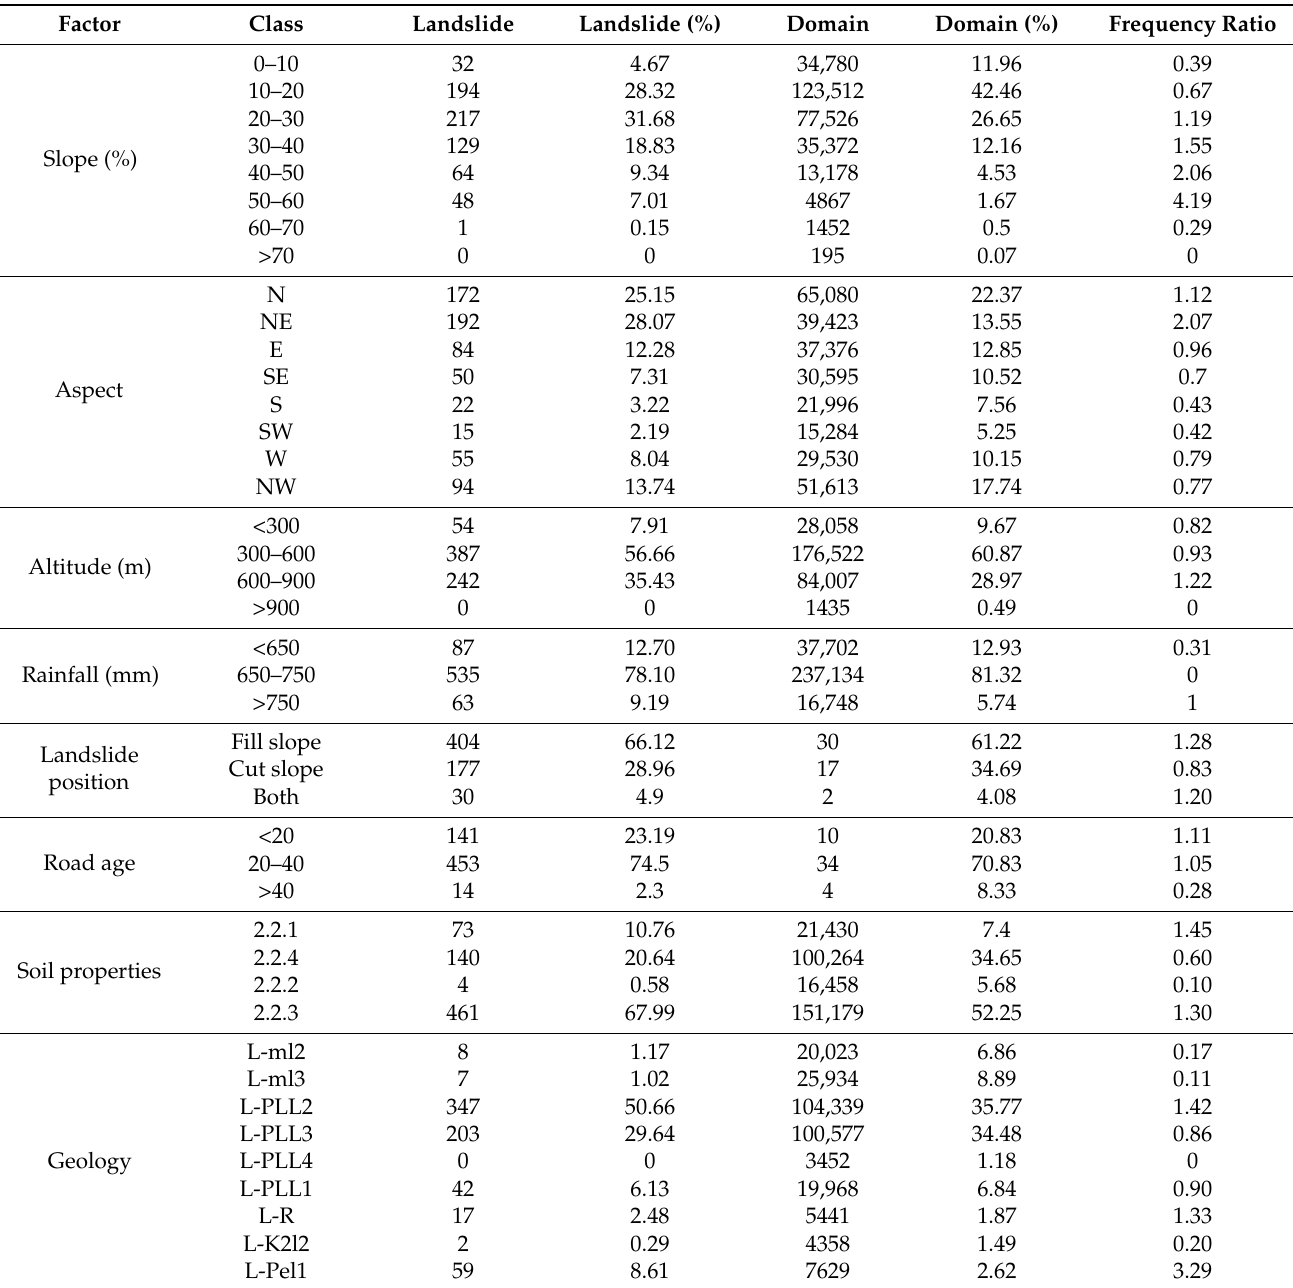
Table 1. Spatial relationship between landslide and landslide-conditioning